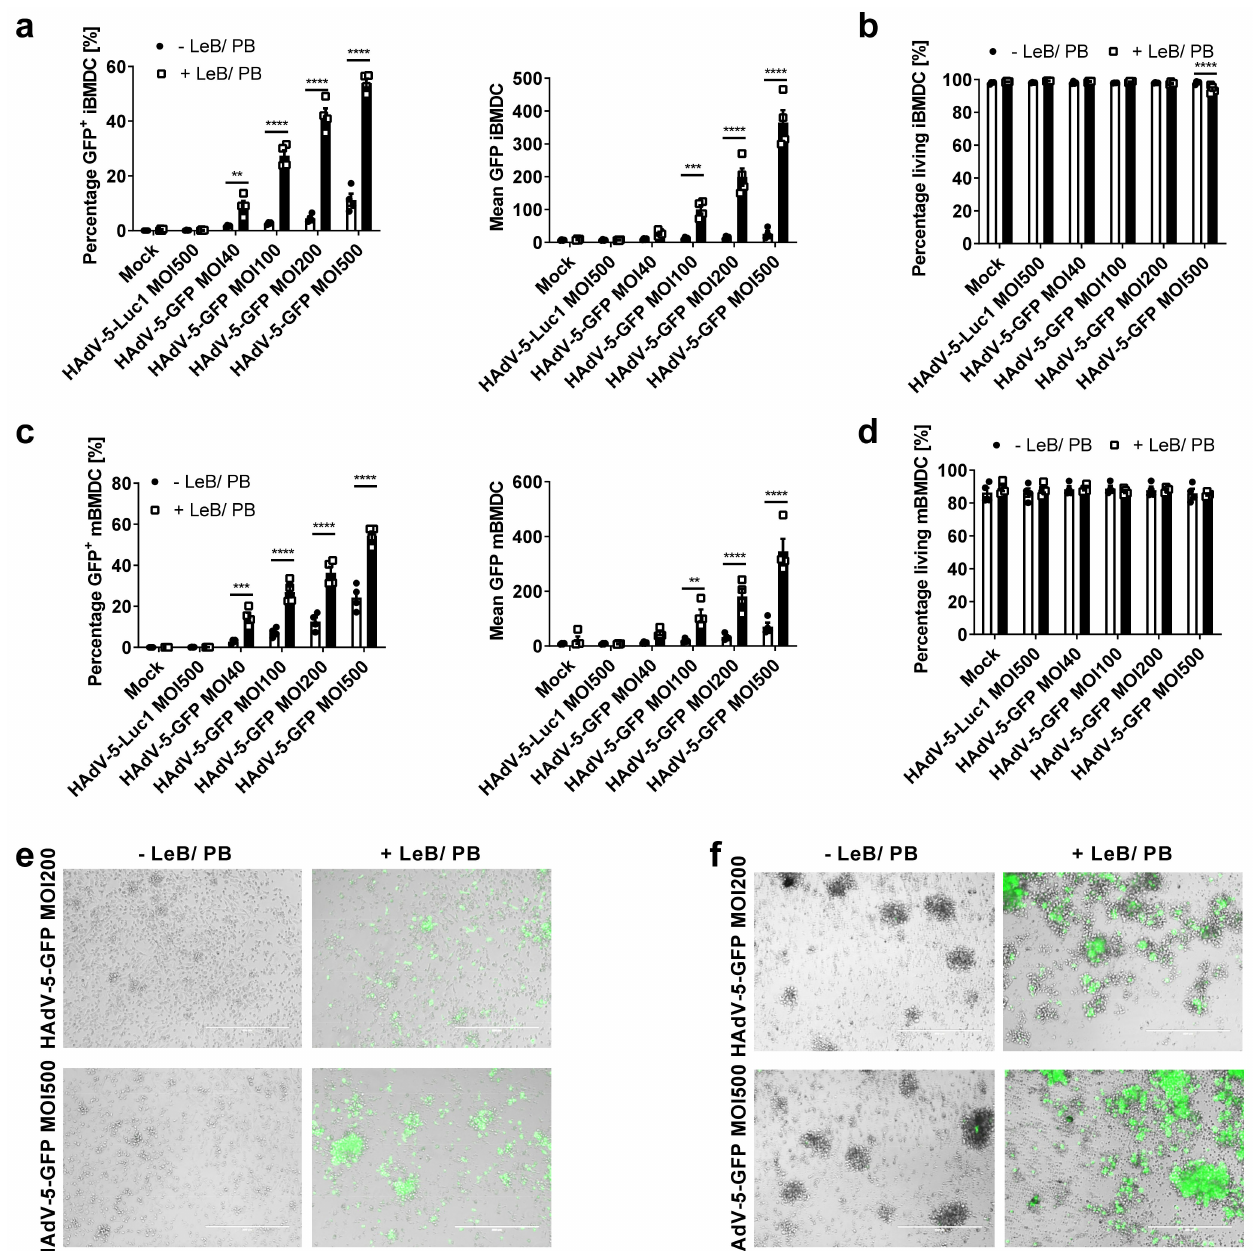
Figure 1. LentiBOOST ® /Polybrene highly increase transduction efficacy of murine BMDCs. Im- mature (i) and LPS-matured (m)BMDCs were transduced with HAdV-5-GFP at different MOIs in combination with LentiBOOST ® /Polybrene (+LeB/PB) or with water (control), for 48 h. As a control, cells were mock-transduced (“Mock”) or transduced using HAdV-5-Luc1. ( a , c ) Flow cytometric anal- yses of iBMDCs ( a ) and mBMDCs. ( c ) GFP expression presented as percentage and mean fluorescence of GFP+ BMDCs. ( b , d ) Flow cytometric analyses of iBMDCs ( b ) and mBMDCs ( d ) regarding 7AAD- living cells. ( a – d ) Data are mean ± SEM of four independent experiments with cells derived from different mice. Two-way ANOVA and Sidak correction were performed. ** p < 0.01, *** p < 0.001, **** p < 0.0001, bars without annotation are not significant ( p > 0.05) in comparison to the respec- tive condition water control. Black circles represent conditions without LentiBOOST ® /Polybrene, white squares represent conditions with LentiBOOST ® /Polybrene. ( e , f ). Fluorescence imaging of HAdV-5-GFP-transduced iBMDCs ( e ) and mBMDCs ( f ) 48 h after transduction. Scale bar (white line) = 400 µ m. One representative experiment out of four is